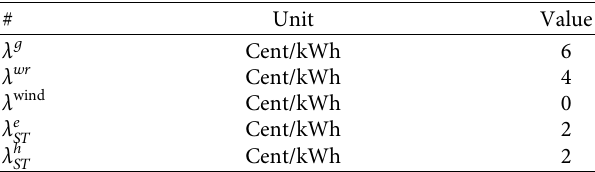
Table 5: Cost of the operation of the local units.